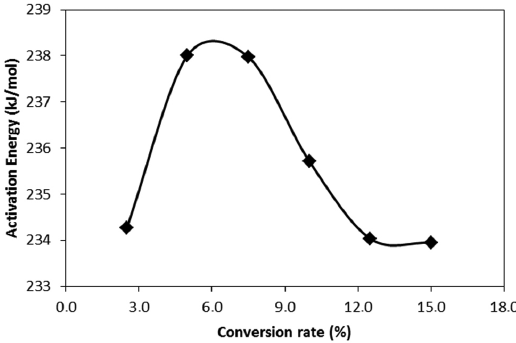
Figure 4. Activation Energies obtained for the conversion rates of 2.5%, 5.0%, 7.5%, 10.0%, 12.5% and 15.0%